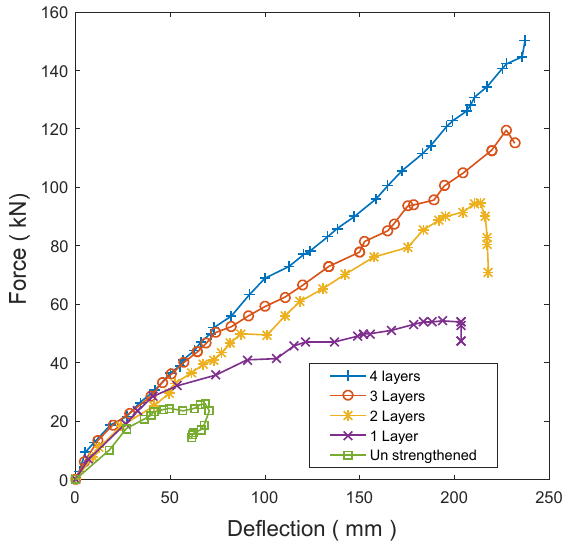
Figure 23. Force–deflection relation for strengthened and unstrengthened slab samples [110]. TRM also has a significant effect on controlling local damage to RC slabs under accidental or deliberate events. Strengthened RC slabs also decline the local damage in RC slabs from the front and back faces, specifically with the same impact velocity. The value of the ejected weight of the slabs in two faces also proves the effectiveness of TRM in strengthening slabs over bare ones (Figure 24). TRM reinforcement accordingly boosts the ballistic limit velocity by approximately 21% [111]. The effect of three various composites of FRCM, C-FRP, and silane modified graphene (SGr) as a method to strengthen one-way RC slabs indicated that such materials boosted the flexural strength of RC slabs around 1.3–2 times than unstrengthened ones. Additionally, the composite material affected the displacement ductility performance of the one-way slab system. The exposed FRCM slab also had a 13% increase in its displacement compared to the unexposed specimens [112].